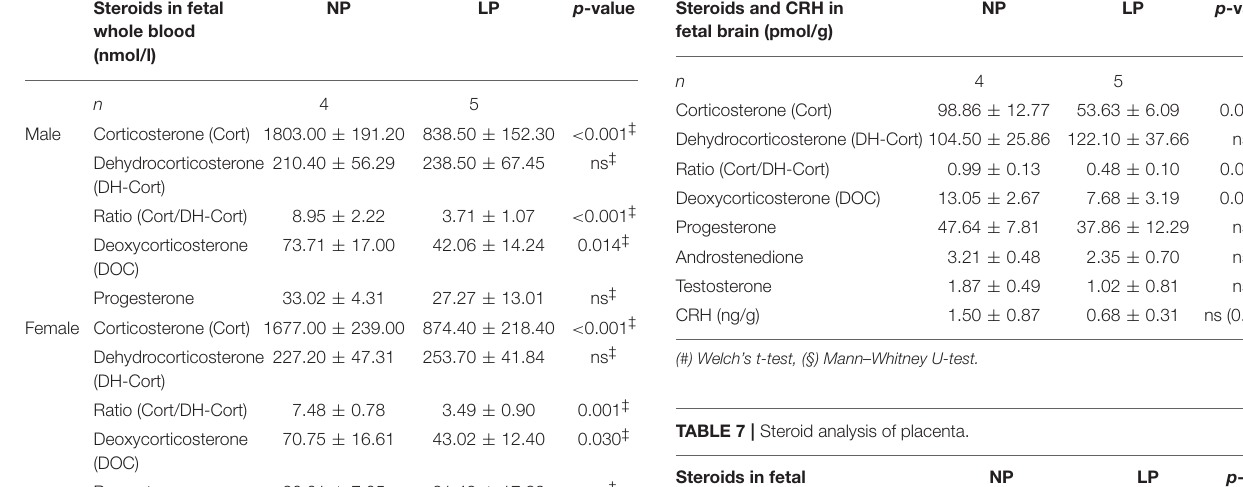
TABLE 5 | Sex-specific steroid analysis of fetal whole blood. Steroids in fetal whole blood